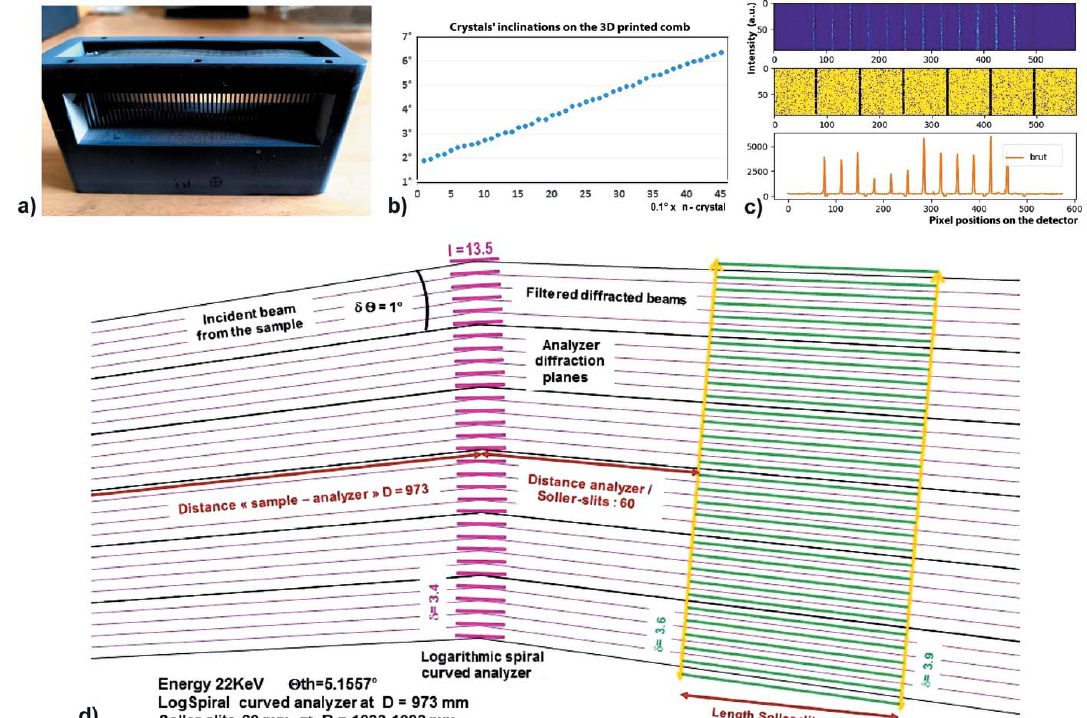
Figure 7 Sandwich-comb analyser block with Si(111) crystals working in reflection mode. ( a ) Sandwich-comb made by 3D printing. In this example we inserted a Si(111) single-crystal plate into all of the slots spaced 1.7 mm apart and corresponding to a crystal pitch of 0.1 (cid:3) . ( b ) Angular measurements of the beam filtered by this block and therefore of the tilt of the analyzer crystals. ( c ) Diffraction measurements filtered by a sandwich-comb having an angular pitch of 0.2 (cid:3) between the Si(111) crystals and being associated with a Soller-collimator block having a pitch of 0.1 (cid:3) (due to the unavailability during this experiment of a Soller collimator with a 0.2 (cid:3) pitch), so this mismatch led to more restrictive intensity cuts of the filtered beams; this Soller-collimator block is fixed on the 2 (cid:2) A arm at a distance ( D s = 1033–1093 mm) from the sample in front of the hybrid photon-counting XPAD S70 detector (Basolo et al. , 2007; Medjoubi et al. , 2010); this 2D detector is made up of a succession of seven chips supporting pixels (yellow zones) and the dimension of each pixel of the XPAD S70 detector is 125 m m. ( d ) Scheme of 22 keV beam paths filtered every 0.2 (cid:3) , over a range of 6 (cid:3) , by two rigid blocks: the sandwich- comb of Si(111) crystals and the Soller-collimator. The distance between the sample and the MAD block is large ( D = 973